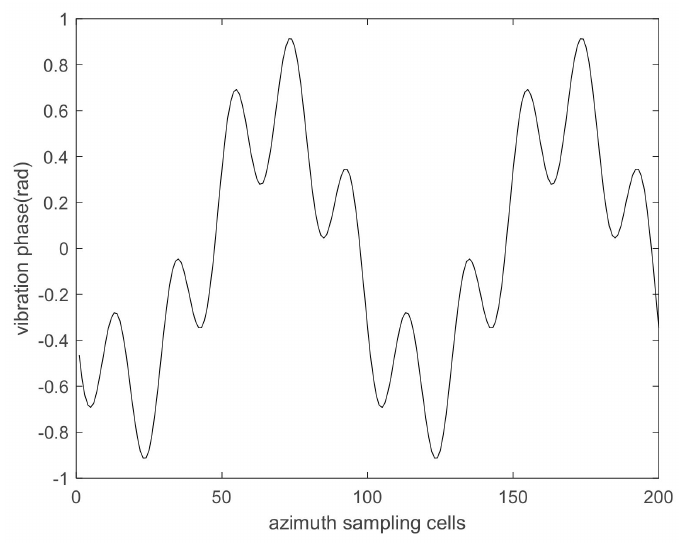
Figure 22. Vibration phase added in the